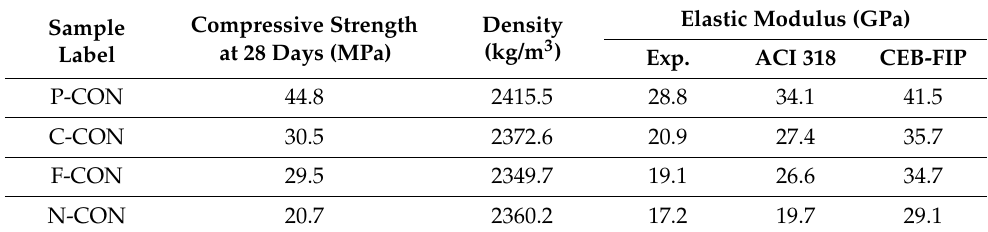
Table 4. The results of elastic modulus using experiments and model